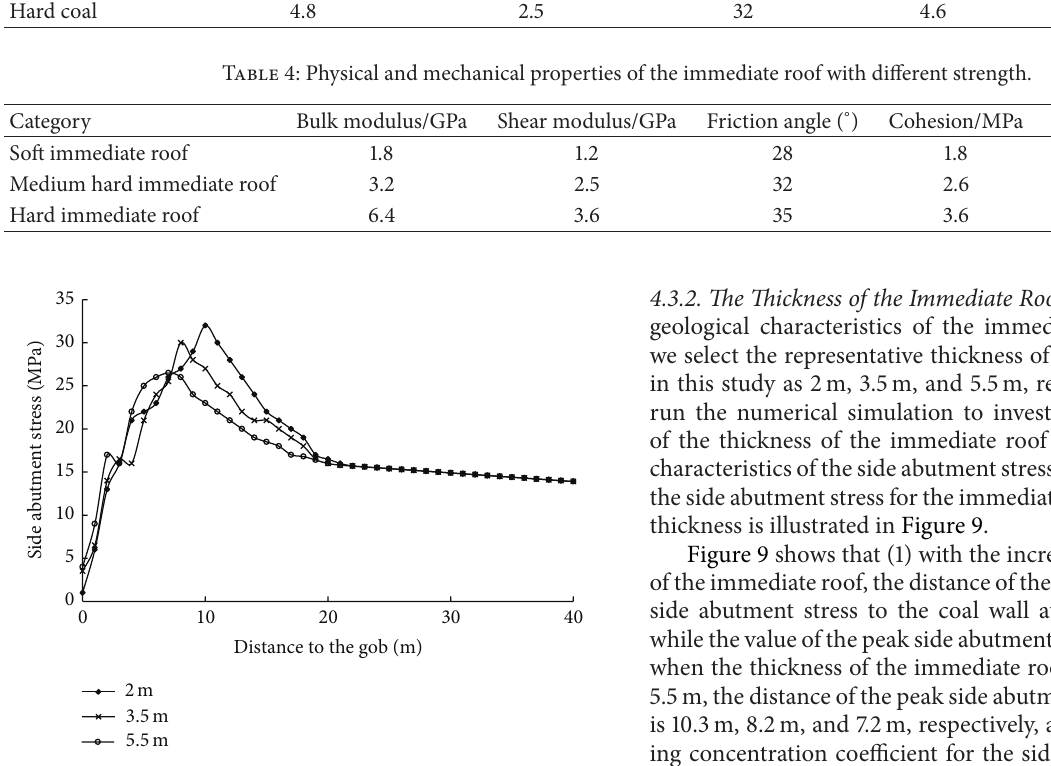
Figure 9: Distribution of the side abutment stress for the immediate roof with different thickness.